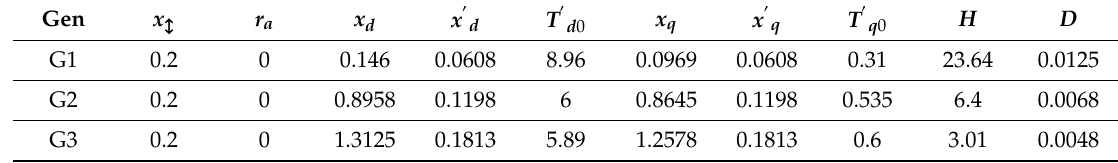
Table A2. Machine dynamic data.